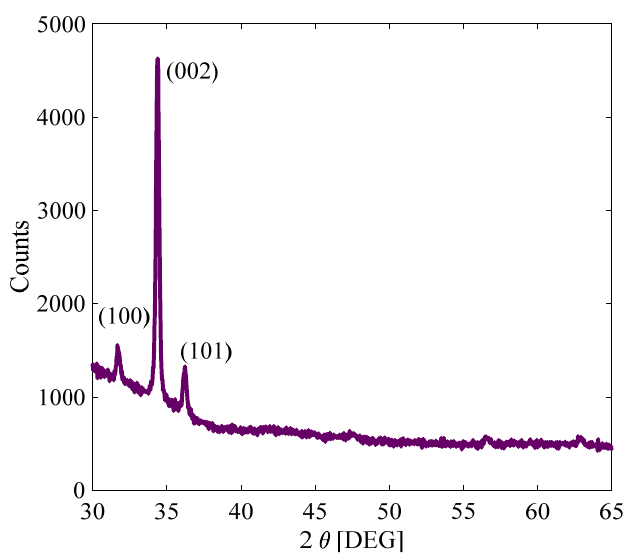
Appl. Sci. 2020 , 10 , x FOR PEER REVIEW Figure 4. XRD pattern showing the principal planes measured in the studied ZnO sample.